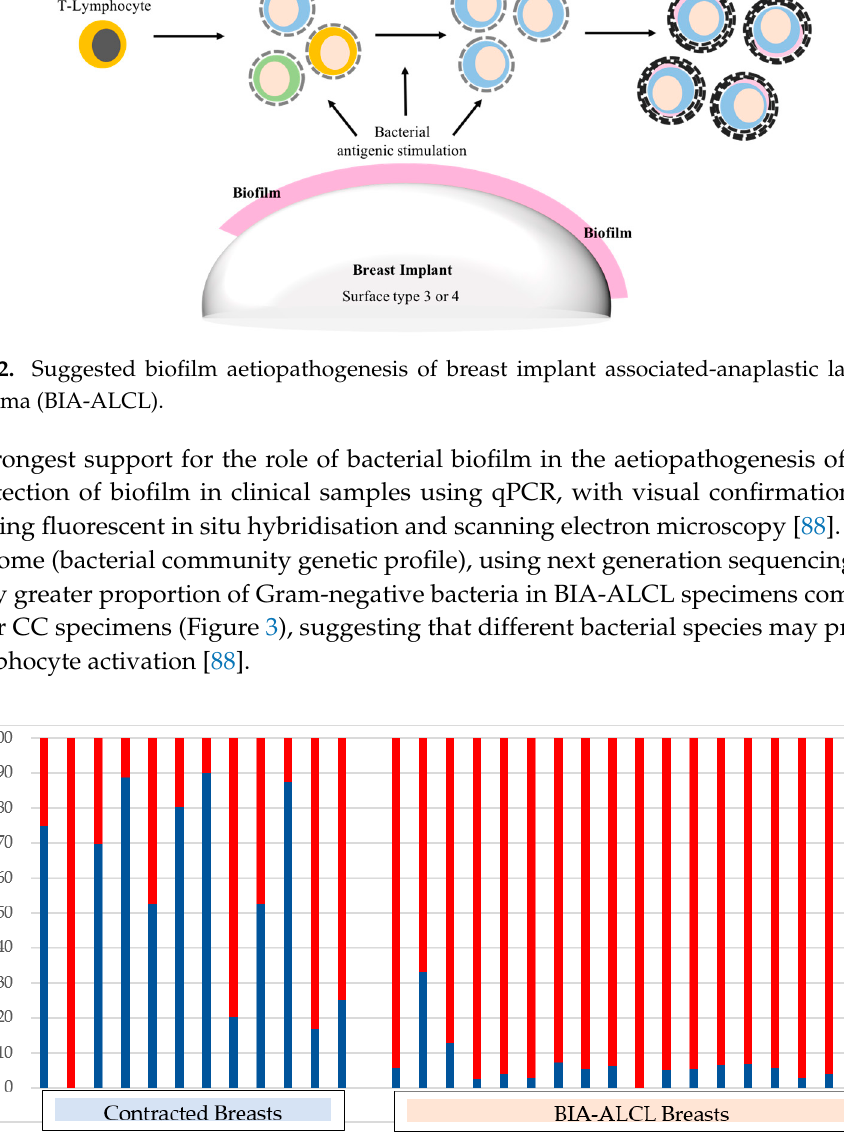
Figure 3. Percentage of Gram-positive (coloured blue) and Gram-negative (coloured red) organisms in capsules obtained from contracted breasts and in BIA-ALCL samples [88].